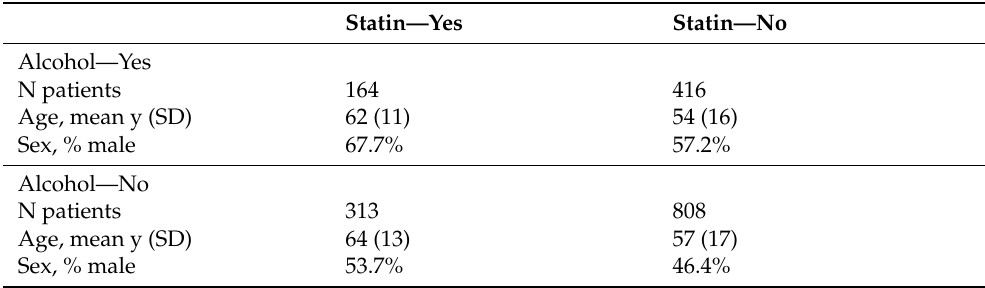
Table 1. Frequencies by Alcohol and Statin Category, together with Age and Sex in Patients at Primary Cardiovascular Risk.